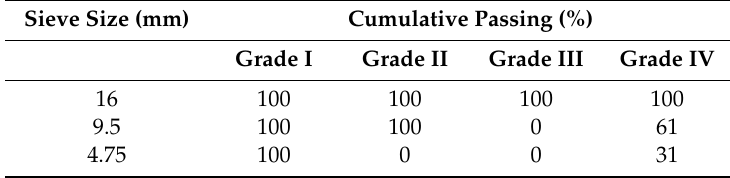
Table 2. Cumulative passing for four aggregate grades.